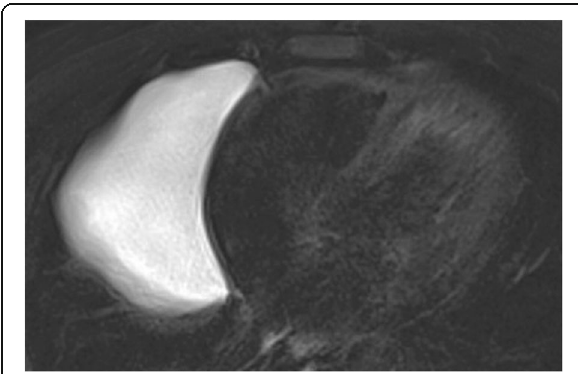
Fig. 13 A 40-year-old man with incidentally detected pericardial cyst. Axial fat-suppressed T2-weighted MR image demonstrates hyperintense cystic mass in the right anterior cardiophrenic angle compatible with a pericardial